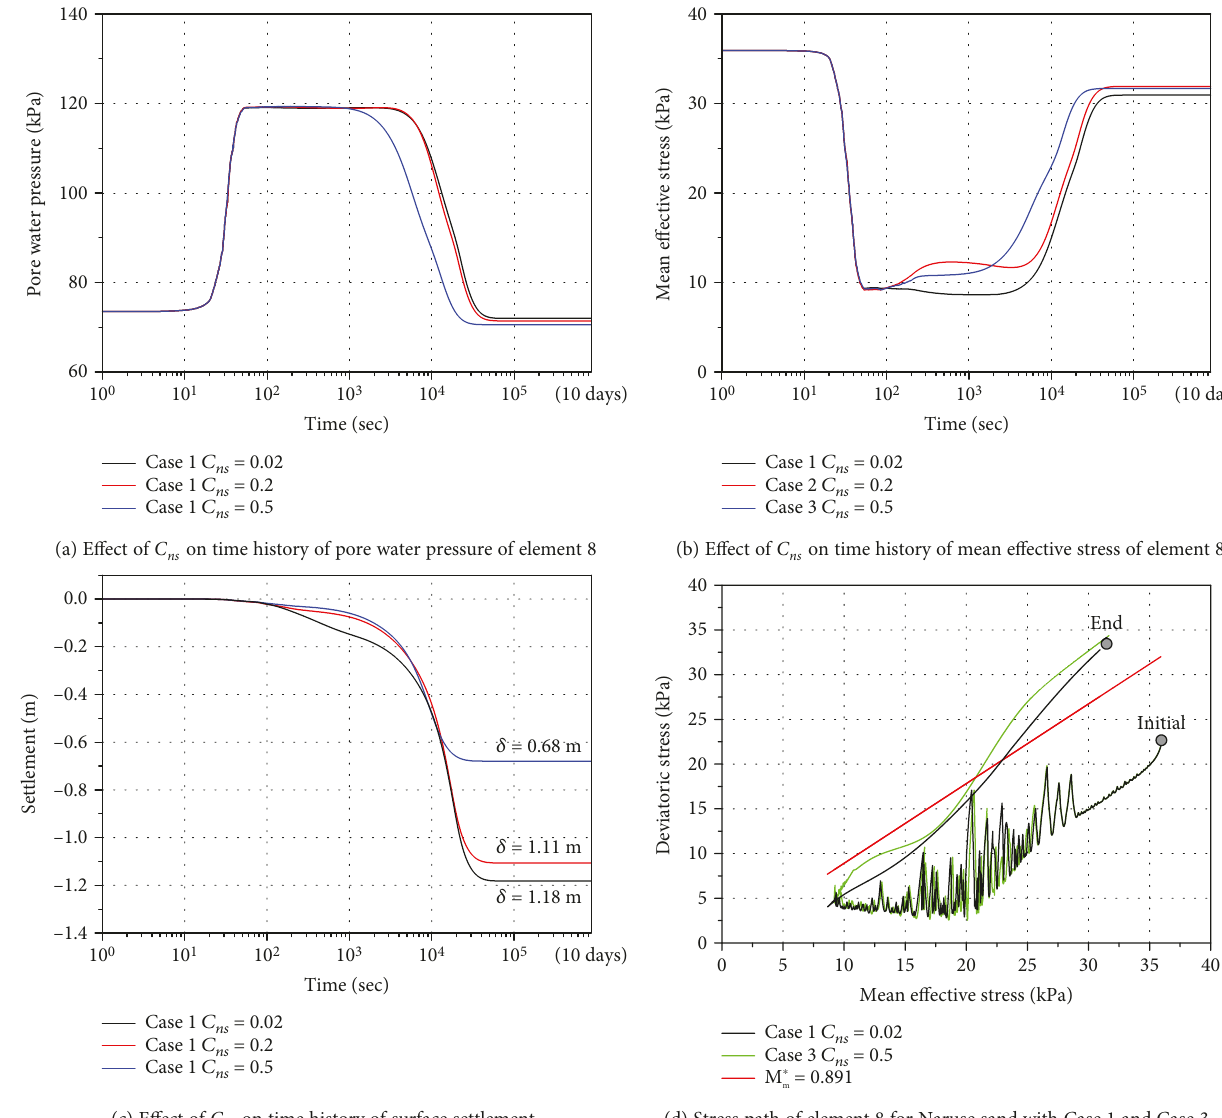
(d) Stress path of element 8 for Naruse sand with Case 1 and Case 3 Figure 6: Parametric study on C ns